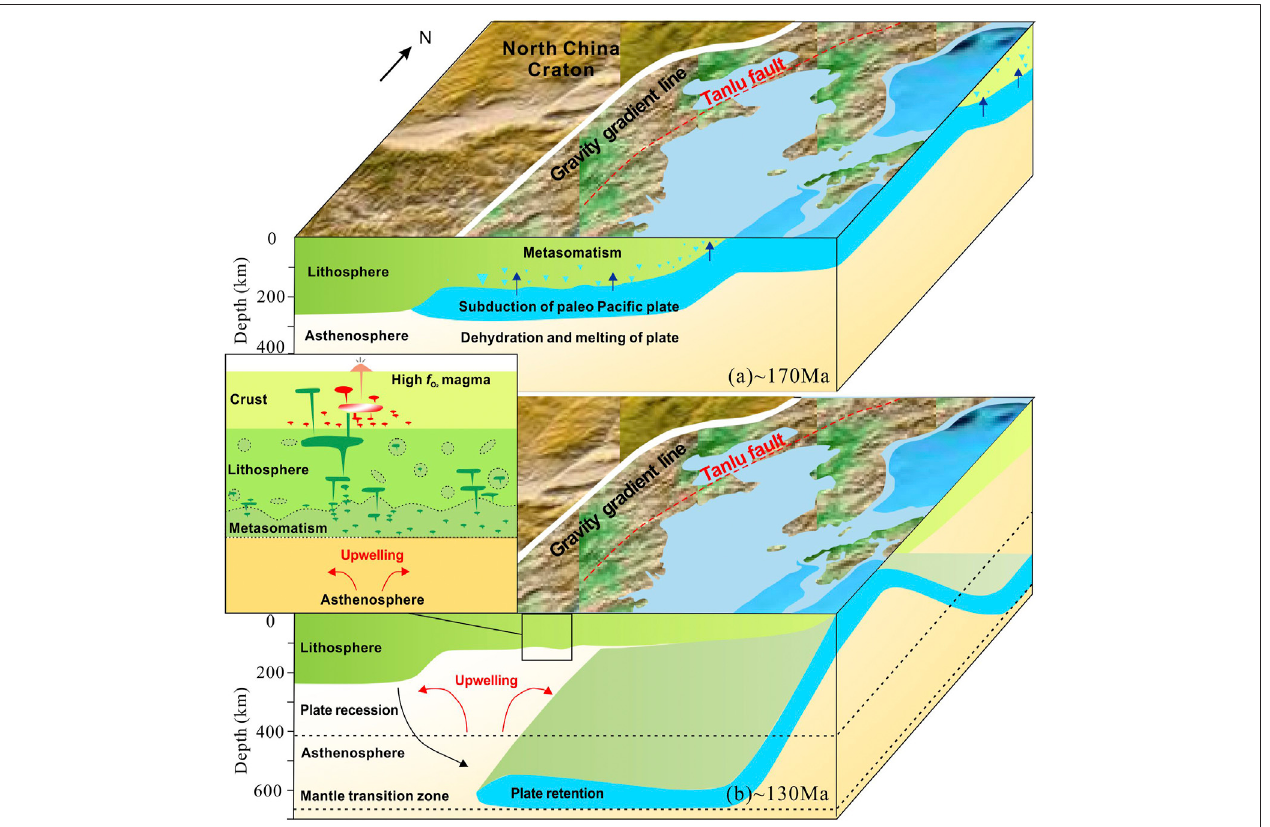
FIGURE 7 | The upwelling mechanism of the mantle-derived thermal material caused by the subduction and retraction of the Paleo-Paci fi c plate. (A) The subduction of thePaleo-Paci fi c plate may have started in the Early Jurassic.Northwestward fl at subductions began in the LateJurassic to Early Cretaceous, which may have reached the inner land and was responsible for the destruction of the NCC (Ling et al., 2009, 2013). Much slab fl uid and melt releases into the overlying mantle wedge. (B) The retreat of the (Paleo)-Paci fi c plate resulted in the upwelling of the asthenospheric mantle and triggered the formation of large-scale high f O 2 intraplate magmas.